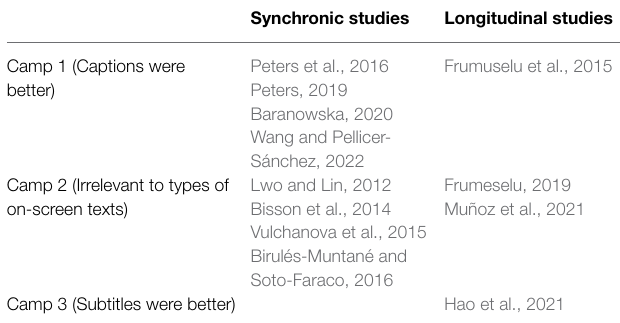
TABLE 1 | Three camps in addressing the optimum type of on-screen